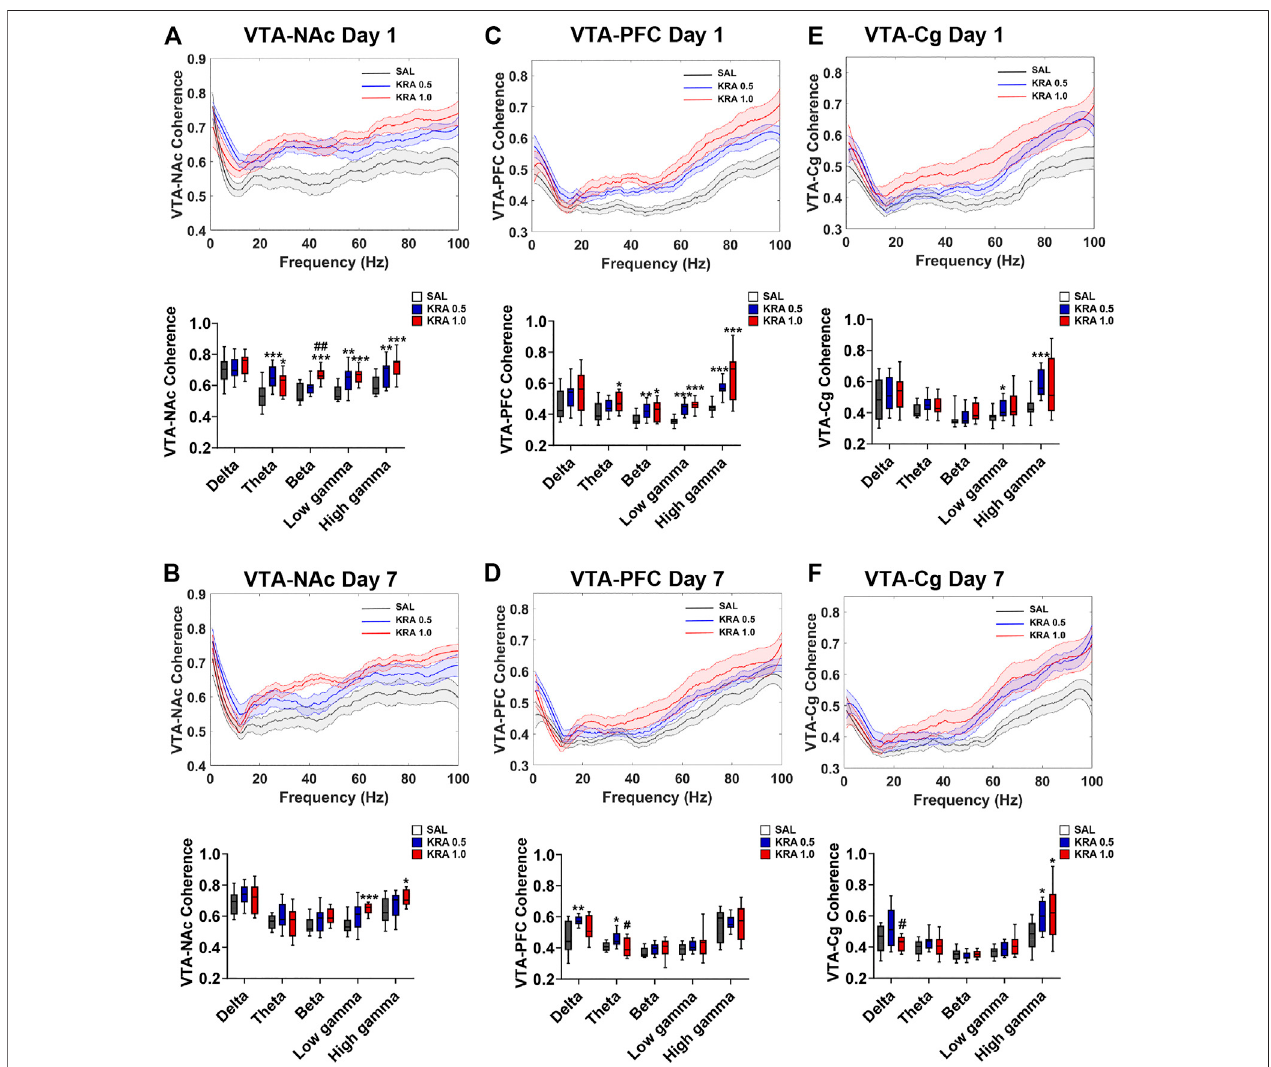
FIGURE7| Dose-dependenteffectsofacuteandrepeatedkratomadministrationonVTA-NAc,VTA-PFC,andVTA-Cgcoherence.Coherenceacrossfrequencies and quanti fi cation showing the effect of acute and repeated low (0.5 mg/kg) or high (1 mg/kg) dose kratom 30 min post-injection. Data shown were taken from 30 s epochs. (A) Highdosekratom increasedVTA-NAcbetacoherencewhereastheta,lowgammaandhighgammacoherencewasincreasedbybothdosesofkratom. (B) On day 7, only high dose kratom increased low and high gamma coherence between VTA-NAc. (C) VTA-PFC coherence was increased in the high frequency bandsinresponsetobothdosesofkratom.Inthethetaband,onlyhighdosekratomincreasedcoherenceonday1. (D) Onday7,repeatedinjectionsoflowdosekratom increased VTA-PFC low frequency coherence. (E) An acute injection of low dose kratom elevated VTA-Cg low and high gamma coherence. (F) Repeated injections of both doses of kratom increased high gamma coherence between VTA-Cg. N (cid:2) 7 – 10 rats per group, with 2 electrodes/rat. Curves are represented as means with jackknife estimates of sem depicted by the shaded areas. Quanti fi cation of coherence are represented as boxplots with min/max values. * p < 0.05, ** p < 0.01, *** p < 0.001 compared to saline control rats. # p < 0.05, ## p < 0.01 compared to low dose kratom treated rats.